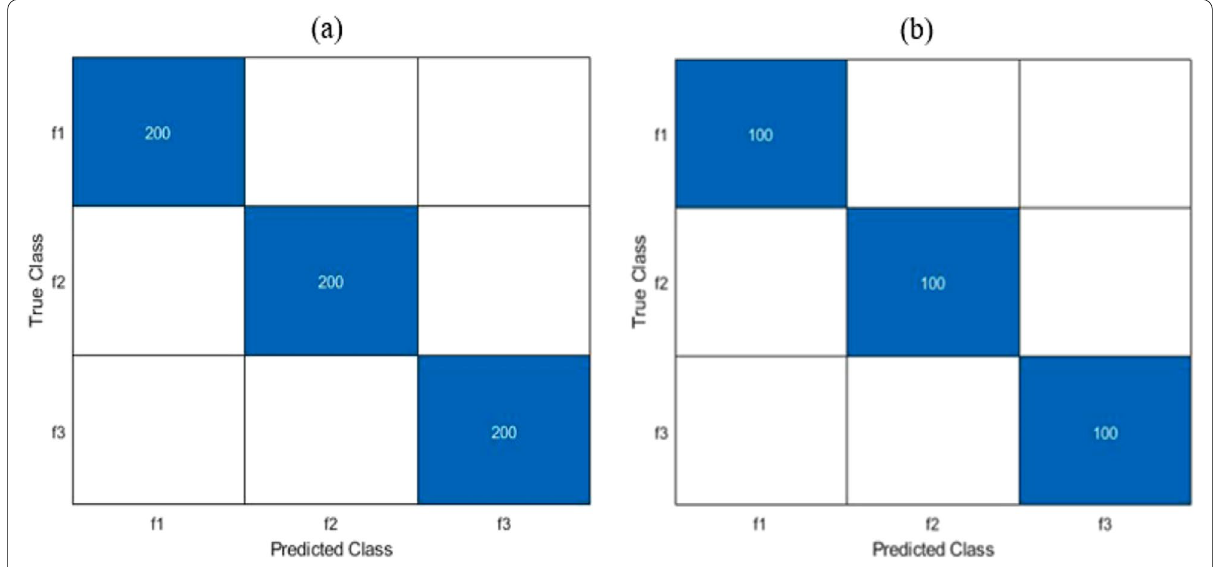
Fig. 7 Confusion matrices for ( a ) validation and ( b ) testing data of the sine signal